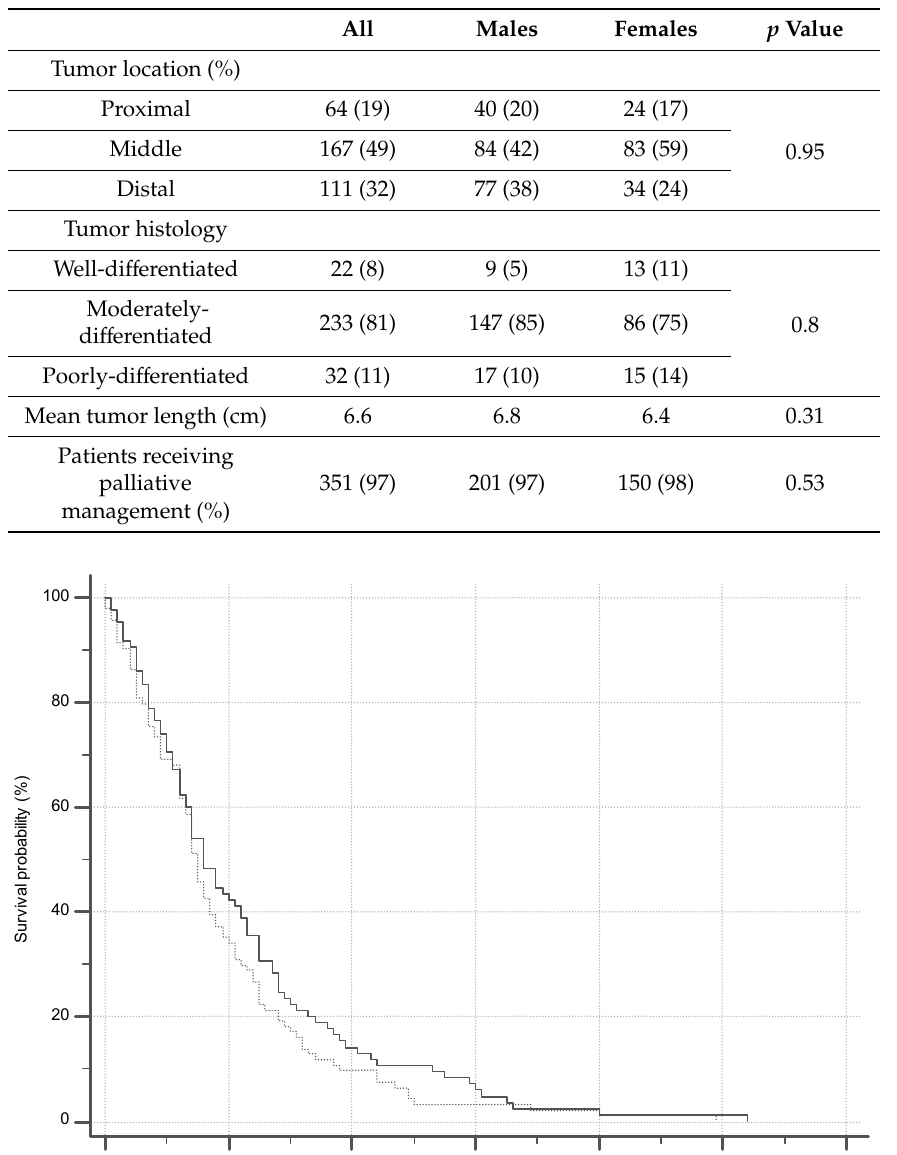
Table 3. Tumor characteristics and management type.